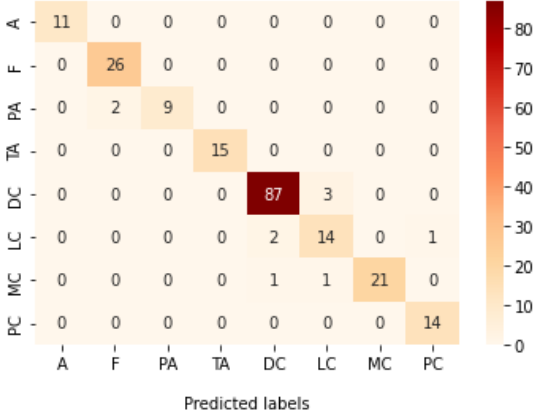
Figure 26. Confusion matrix of Xception model in 100× magnification-dependent multi-classifica- tion.